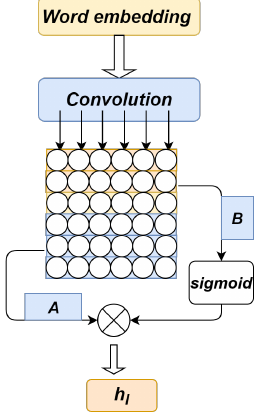
Figure 4. The structure of the gated linear units (GLUs).